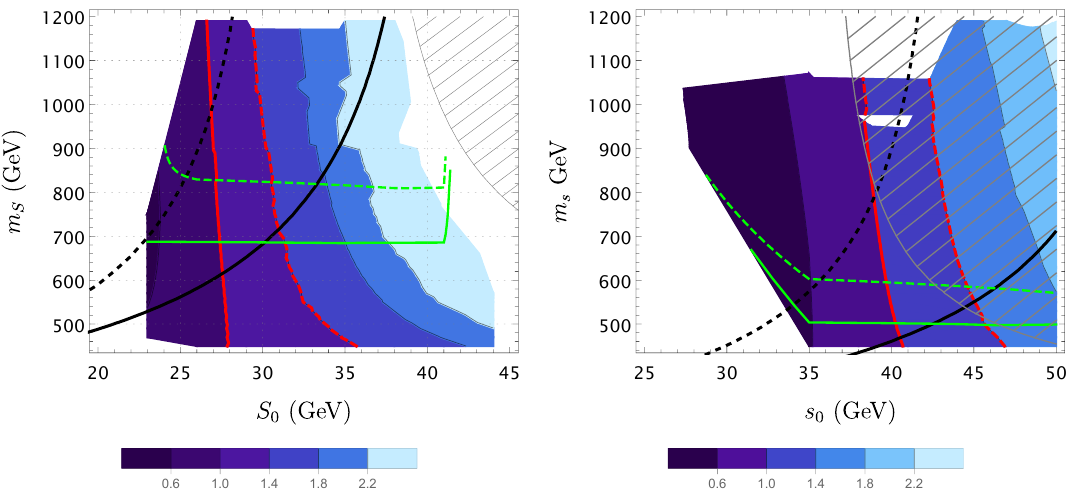
(a) Strength of the first order phase transition R N as function of the singlet vev s 0 and mass m s in the Higgs-singlet model with κ = 4 (left plot) and κ = 2 (right plot). The gray arched area in top right corner is excluded by the 2 σ constraint on the mixing parameter; the 3 σ constraint does not affect parameter space. The white hole that appears in the top-right figure around m s ∼ 1 TeV, s 0 ∼ 40 GeV is most likely a numerical artifact.